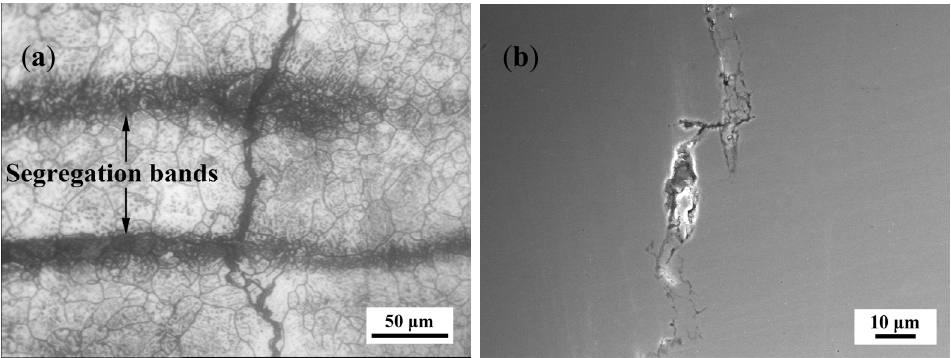
Figure 2. Crack morphology in a segregation zone (SZ) on the flame cutting surface. ( a ) Optical microscopy image and ( b ) scanning electron microscopy image.